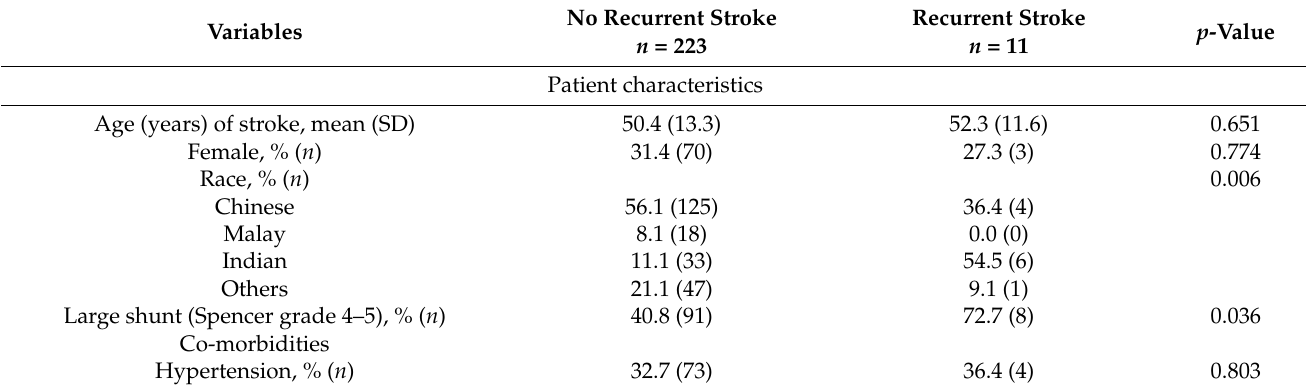
Table 3. Univariate analysis evaluating associations of recurrent ischemic